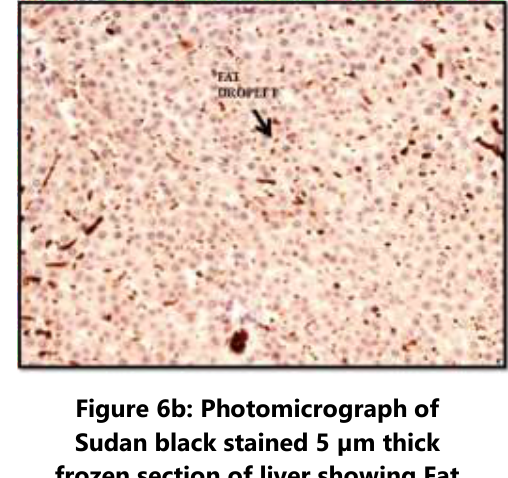
Figure 6a: Photomicrograph of H&E stained 4 µm thick liver section showing fewer Fat droplets (vacuoles) in rat hepatocytes on high-fat diet + Ginseng 200mg/kg (group 4) at ×400.